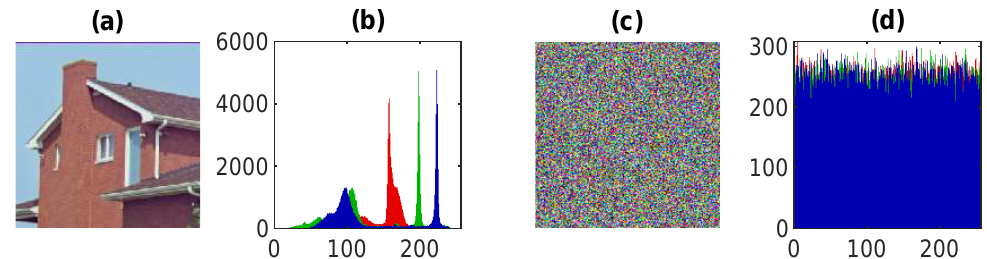
Figure 9. Histogram analysis of the image in Figure 2b: ( a ) the original image, ( b ) histogram of the original image, ( c ) encrypted image, ( d ) histogram of the encrypted image.